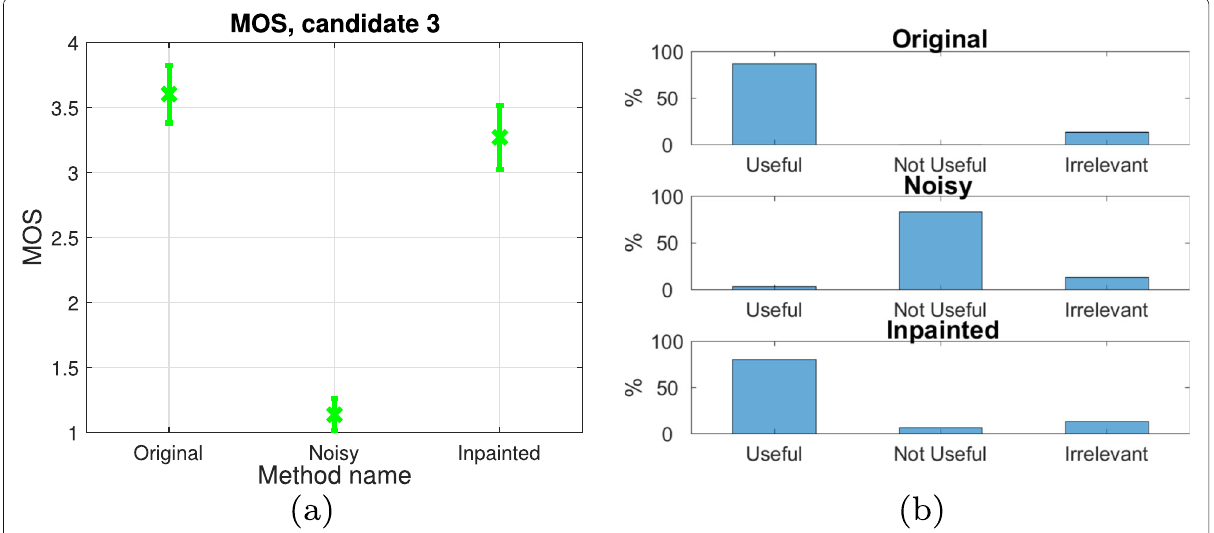
Fig. 10 Results from subjective test for candidate 3. a MOS score (4 refers to highest quality). b Histogram showing usefulness of